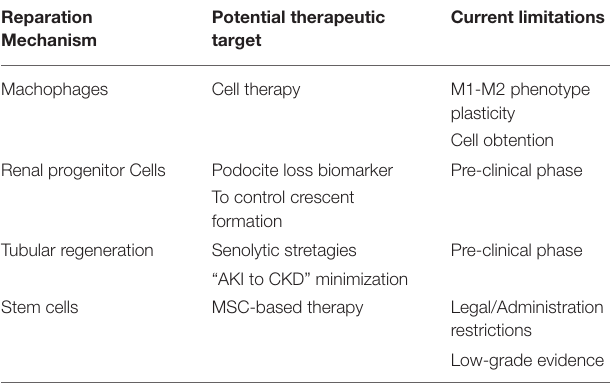
TABLE 3 | Kidney regeneration